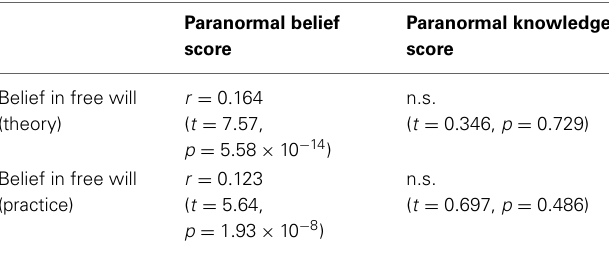
Table 2 | Correlations between belief in free will (theory/practive) and paranormal belief/knowledge scores.